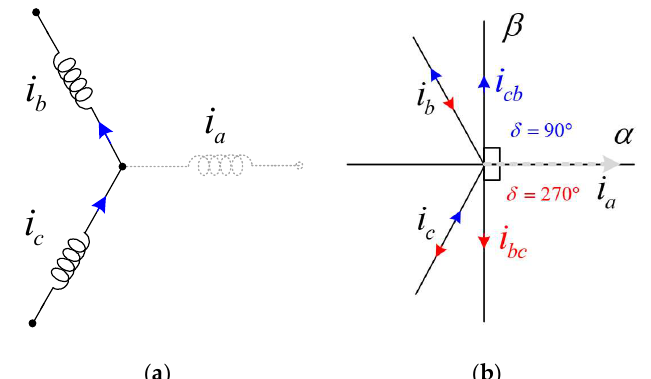
Figure 1. Fault-tolerant inverter.